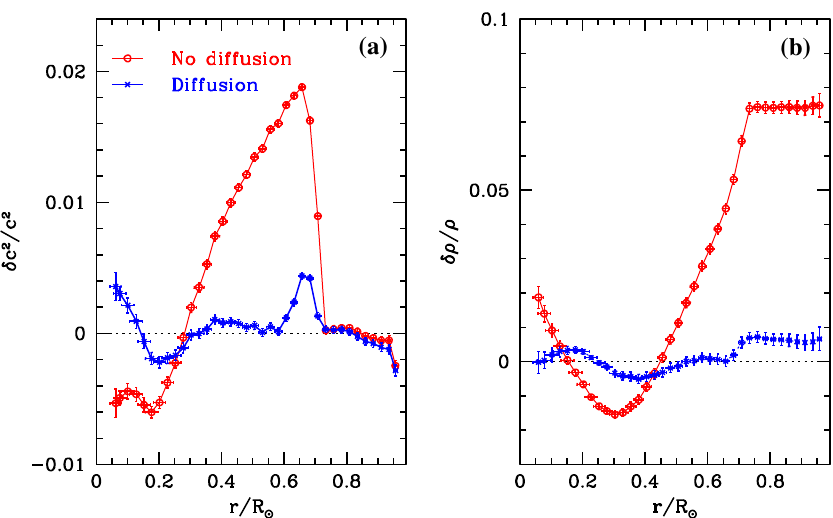
Fig. 20 The relative differences in the squared sound speed ( a ) and density ( b ) between the Sun and two solar models obtained by inverting the frequency differences shown in Fig. 5. Note the model